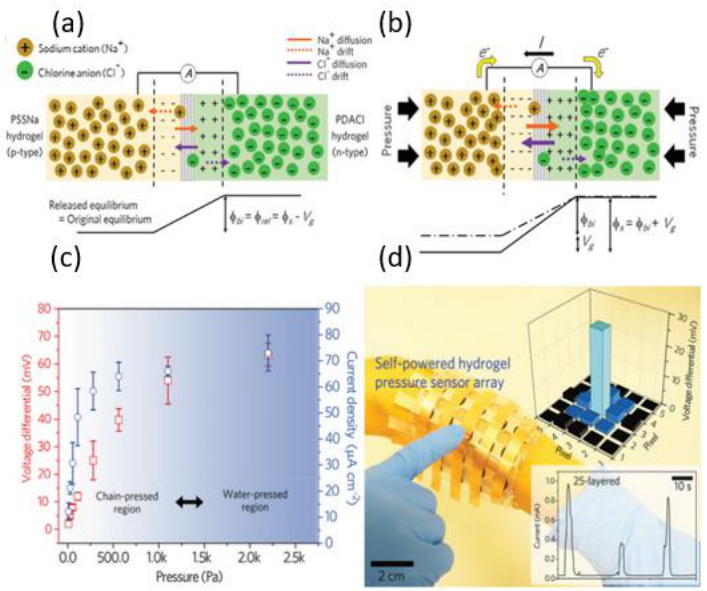
Figure 10. ( a ) The electrical behavior and response of the ionic diode including potential diagram. ( b ) The electrical behavior and response of the ionic diode under external mechanical stress. ( c ) Voltage and current output generated at various external pressures. ( d ) Picture of an arm-wrapped self-powered hydrogel tactile sensor array. Insets: (top panel) voltage signal mapping obtained by pushing the center pixel. (Reprinted with permission from [82] .)